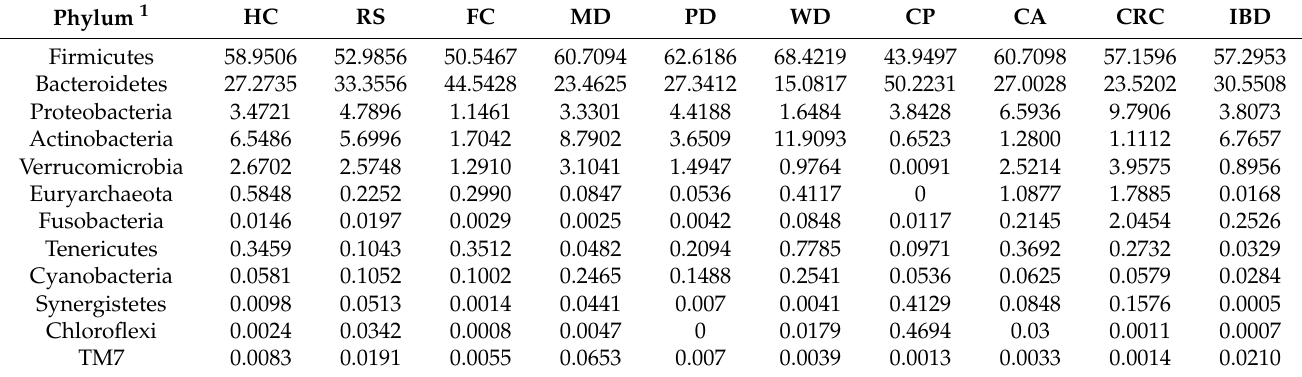
Table 2. Average OTU composition (%) of the different groups at phylum level.